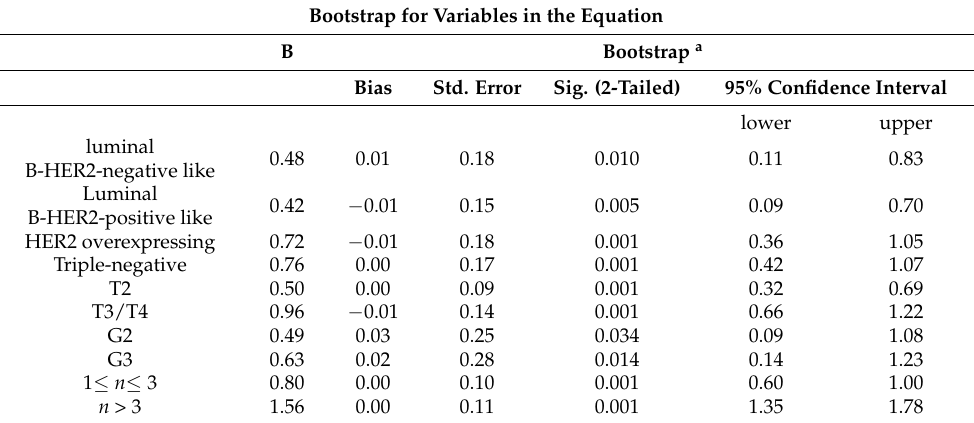
Table 3. Bootstrap results based on 1000 bootstrap samples (internal validation) B beta coefficients. Bootstrap for Variables in the Equation B Bootstrap a